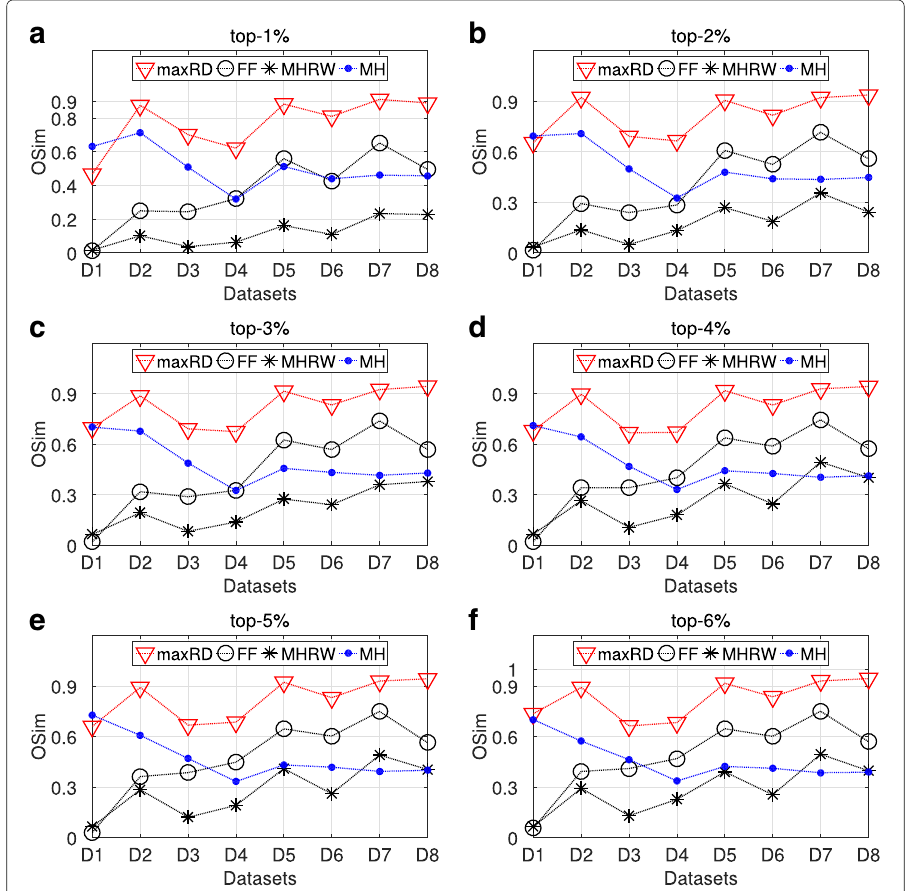
Fig. 8 Comparison of the sampling methods. SIR epidemic. a - f average OSim values based on the degree centrality values, obtained from the 100 samples of each method